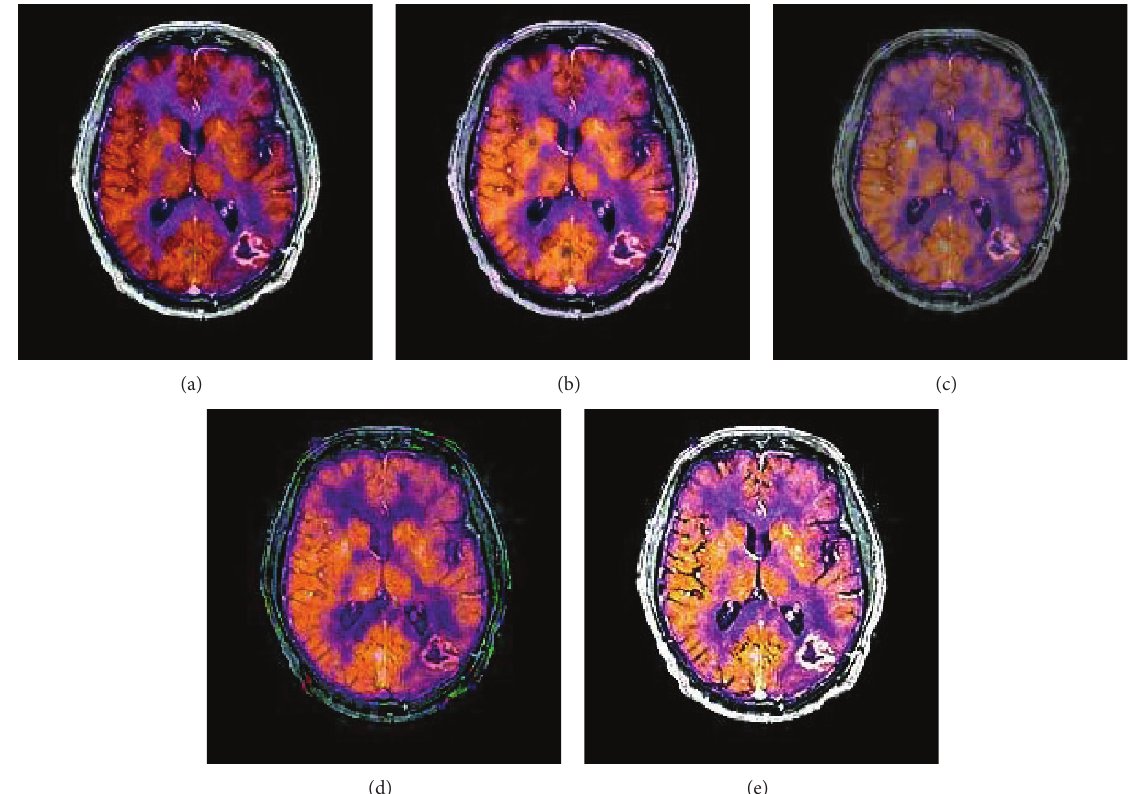
Figure 3: Image fusion results for grade II astrocytoma images: (a) DWT [12]; (b) GIHS [6]; (c) GFF [33]; (d) IAWP [23]; (e) proposed technique.